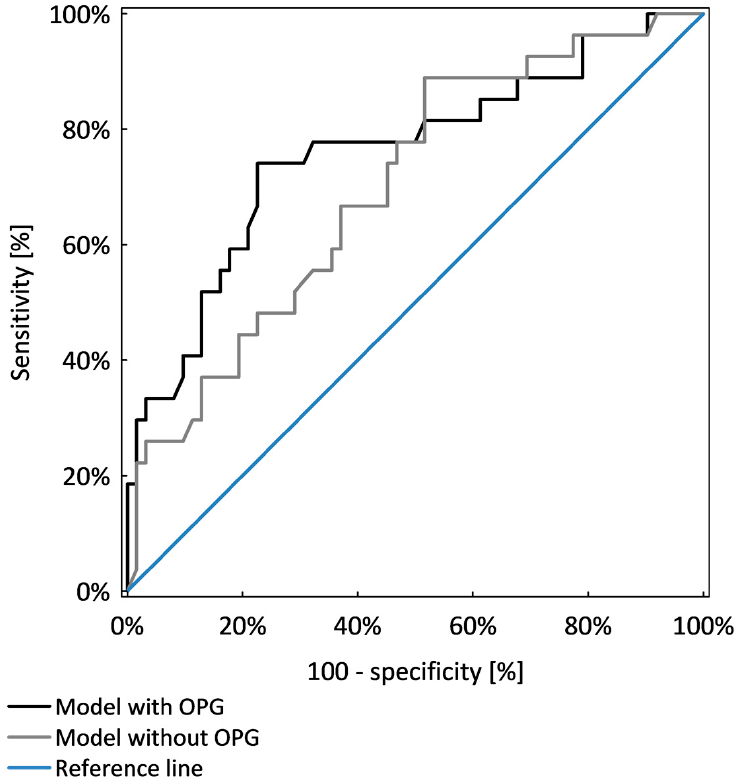
Figure 4. Comparison of two models of logistic regression analysis identifying CKD patients with poor prognostic